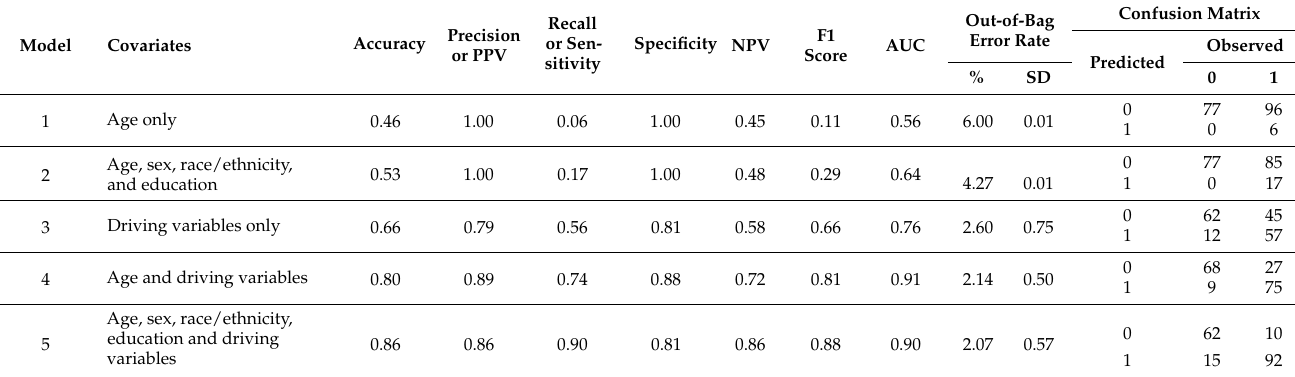
PPV, positive predictive value; NPV, negative predictive value; AUC, area under the receiver operating characteristic curve. Model 5 with combined demographic characteristics and driving variables